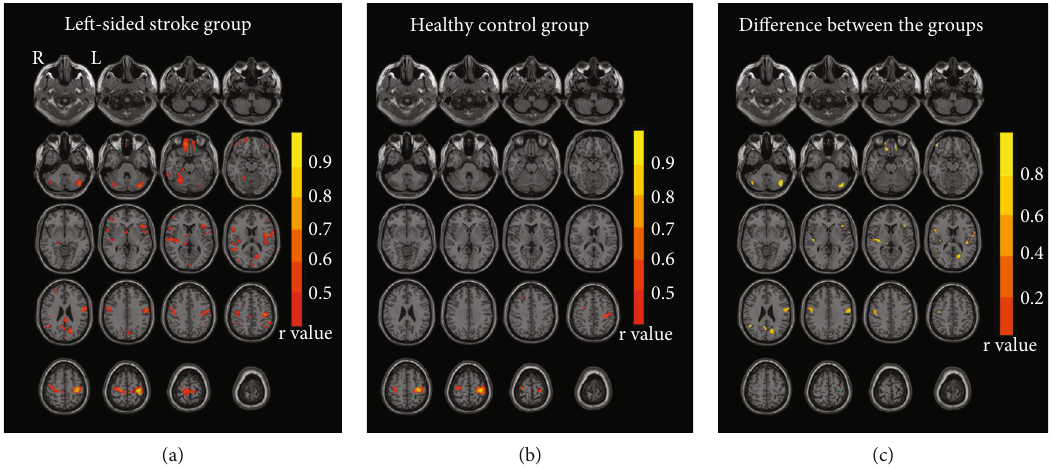
Figure 3: Structural covariance maps and group comparisons in left-sided stroke patients and healthy controls. (a) Structural covariance map of the ipsilesional M1 (left side) in the left-sided stroke group ( p < 0 : 001 , uncorrected). (b) Structural covariance map of the ipsilesional M1 (left side) in the healthy controls ( p < 0 : 001 , uncorrected). (c) Group comparison between the left-sided stroke group and the healthy controls group ( p < 0 : 001 , uncorrected) and the di ff erences in correlation coe ffi cients between the two groups (stroke group minus healthy controls group) in the positive brain regions. The cyan circle shows the location of the seed point (the ipsilesional M1). Abbreviations: L =left hemisphere; R =right hemisphere; HC =healthy controls.